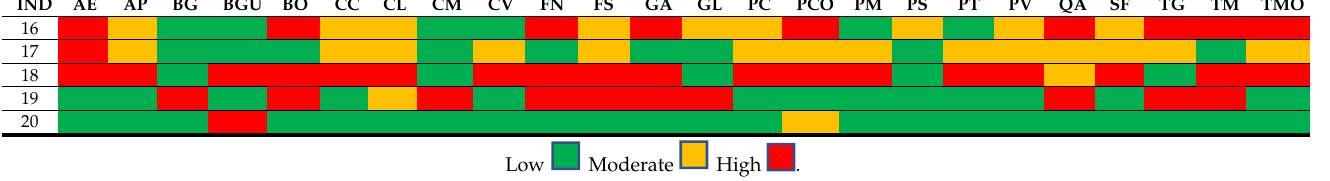
Table 6. Results obtained for the Infrastructure indicators of the different UFs.